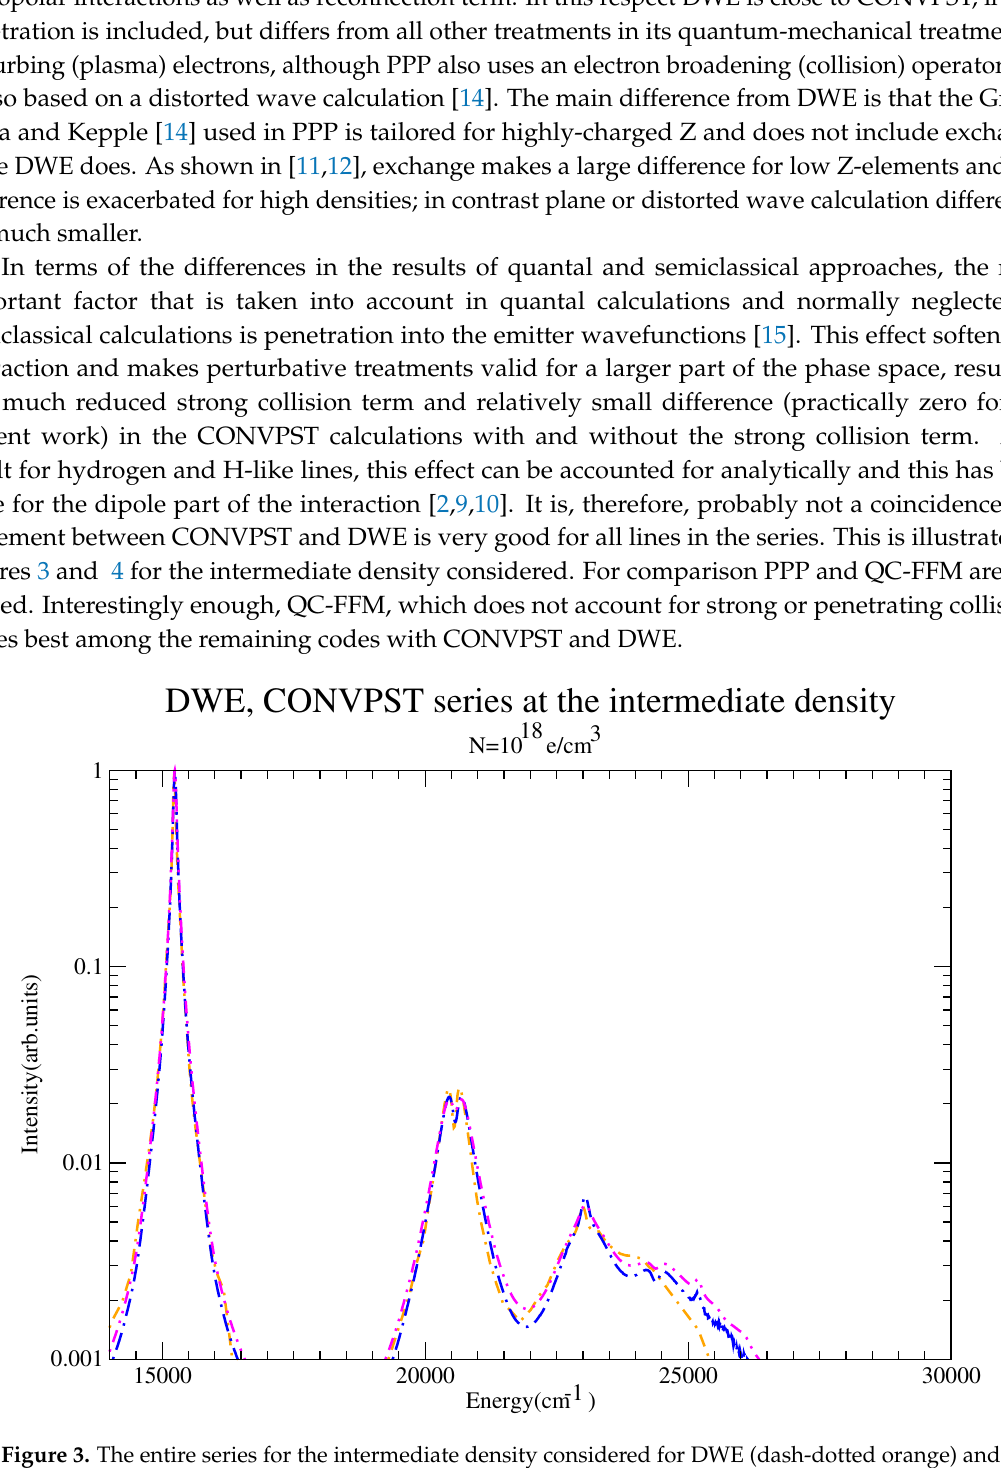
Figure 3. The entire series for the intermediate density considered for DWE (dash-dotted orange) and CONVPST without (long dash-dotted blue) and with strong collisions (dash-double dotted